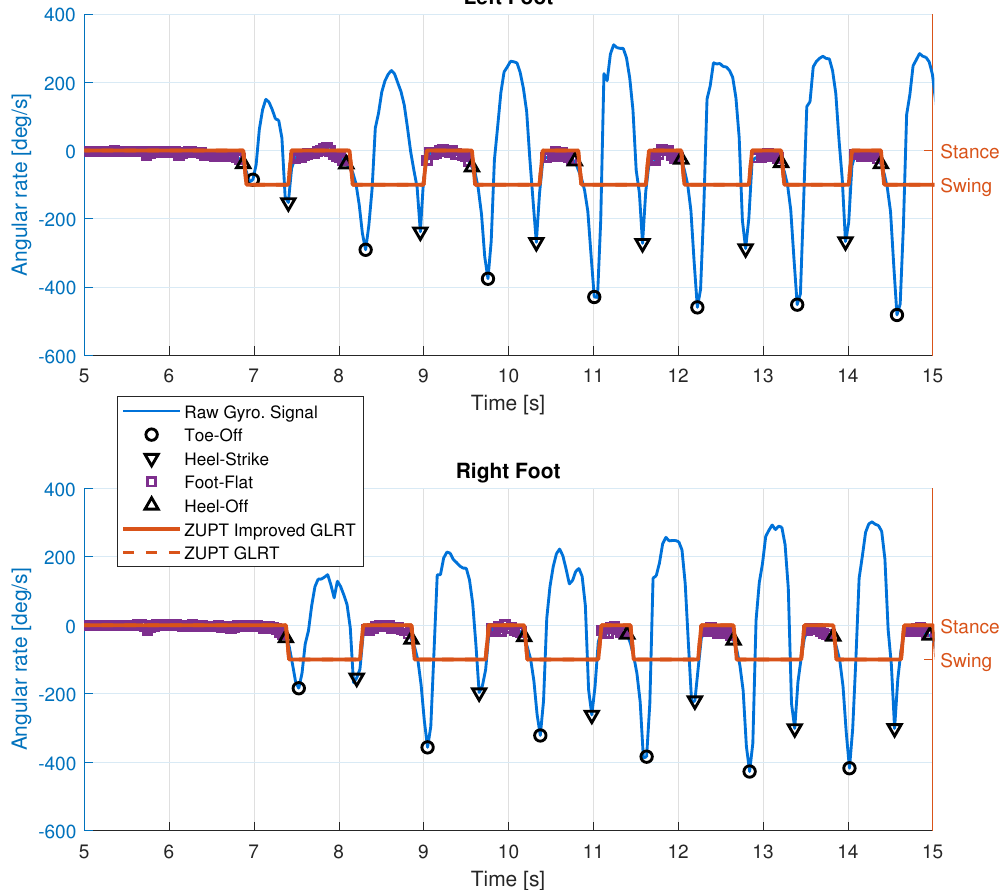
Figure 8. Results of foot gait events and quasi-static periods for left foot ( top ) and right foot ( bottom ). The gyroscope measurements shown are the signals on the sagittal